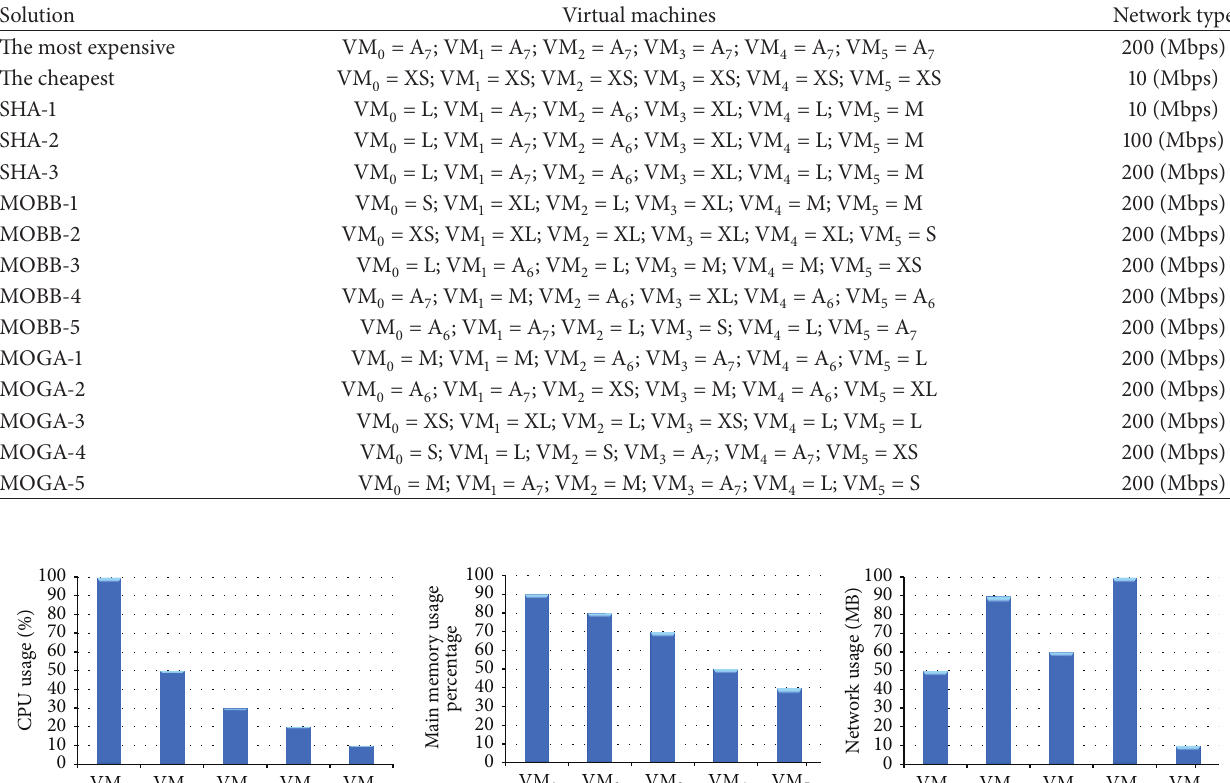
Table 12: Proposed paretooptimal VM and network configurations for workload 3.